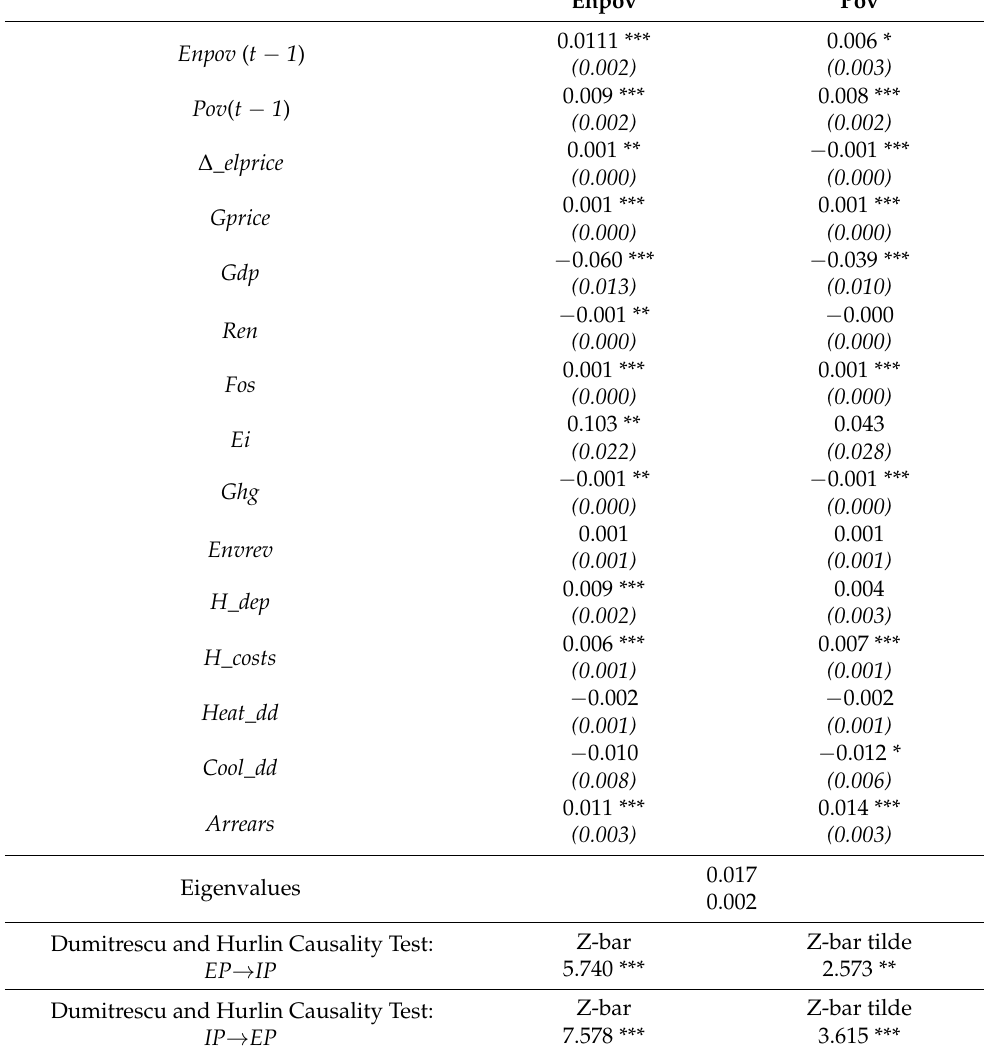
Table 3. GMM Estimates (standard errors in